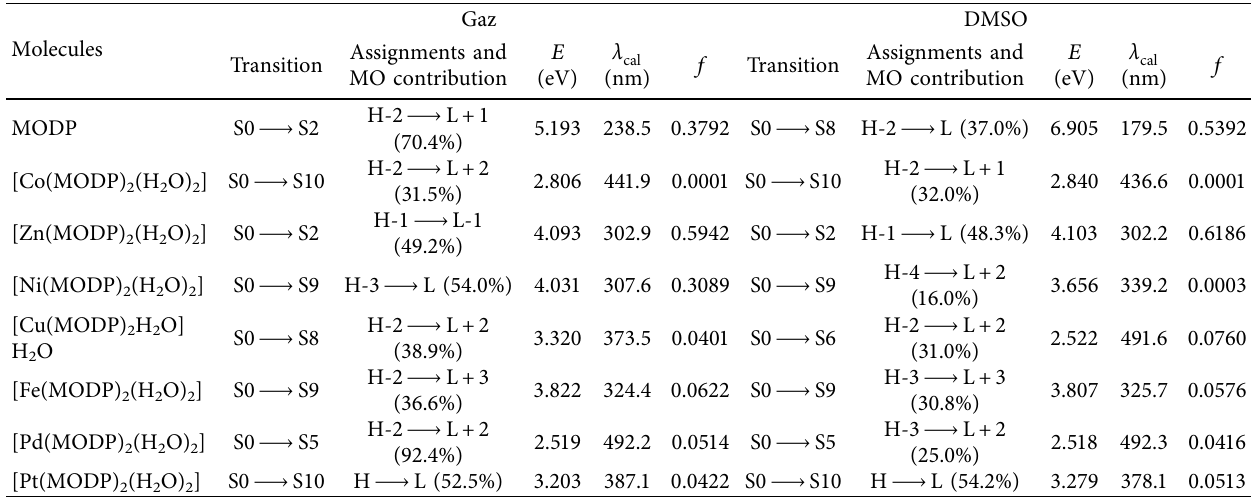
Table 6: Absorption spectra data calculated by TD-DFTmethods for species at CAMB3LYP/def2-TZVP level of theory in the gas phase and in DMSO.